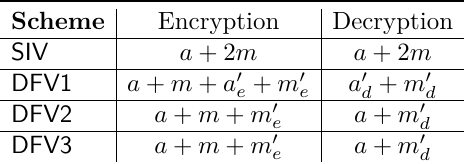
Table 2: Detailed Comparison with SIV